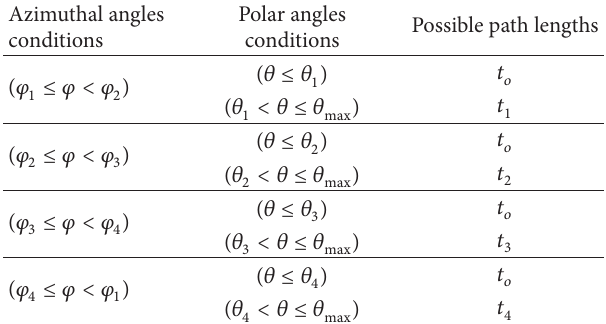
Table 4: The possible path lengths inside the source container material. Azimuthal angles conditions